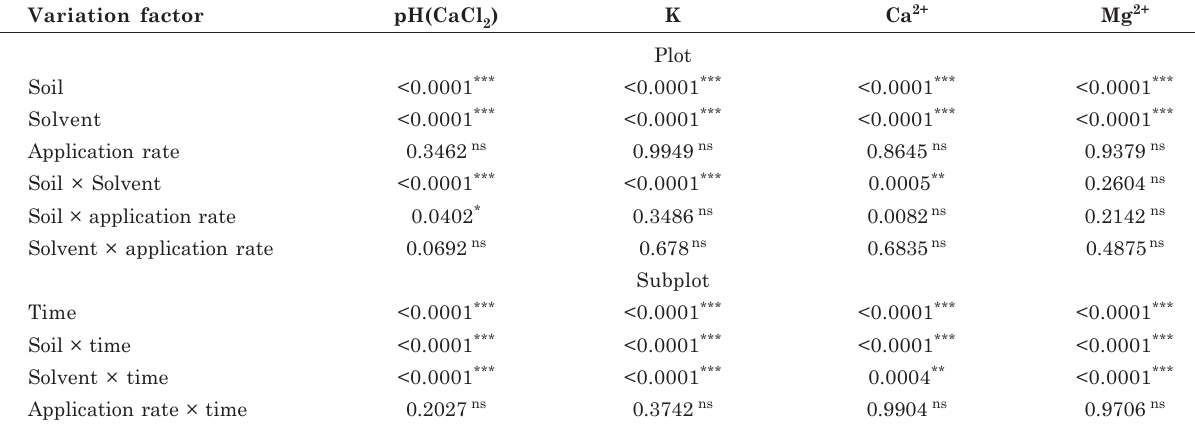
Table 2. Probabilities of significance for the plot and subplot interactions in the